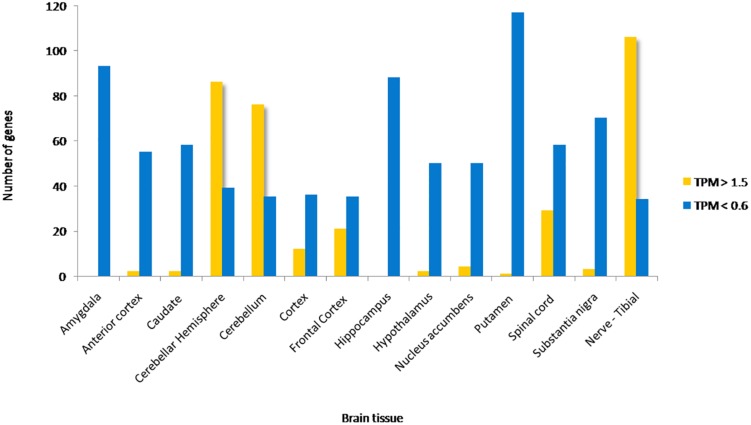
Proportion of phosphoinositide signaling genes with high and low expression in brain regions. The proportion of genes encoding members of the phosphoinositide signaling pathway with TPM values greater than 1.5 and less than 0.6 in specific brain regions are represented as a bar graph. Yellow bars represent TPM > 1.5, i.e., high expression genes and Blue bars represent TPM < 0.6, i.e., low expression genes.